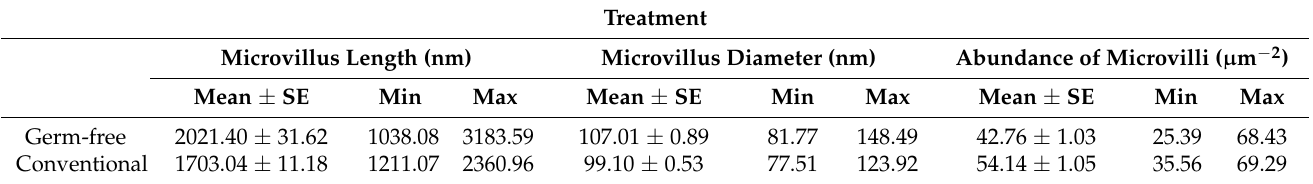
Table 1. Average length, diameter and abundance of microvilli in germ-free and conventional cod larvae at 16 dph. n = 3 cod larvae per treatment were